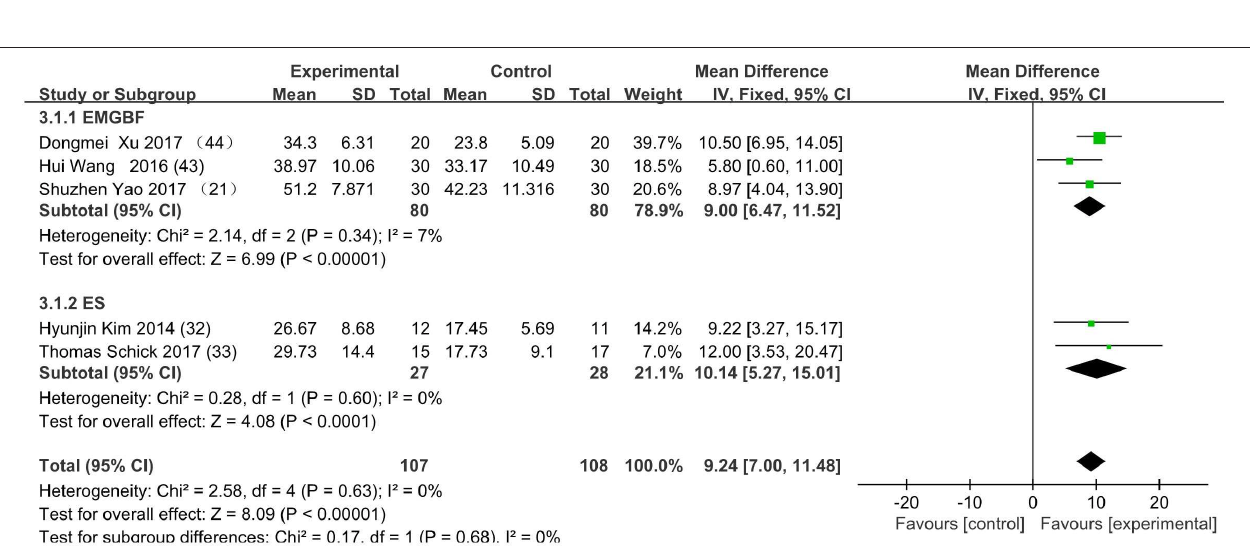
FIGURE 5 | The subgroup’s control method is adding MT to rehabilitation therapy in experimental group. EMGBF group: (E: EMGBF + MT/C: EMGBT); ES group: (E: ES + MT/C: ES) E: experimental group; C: control group.